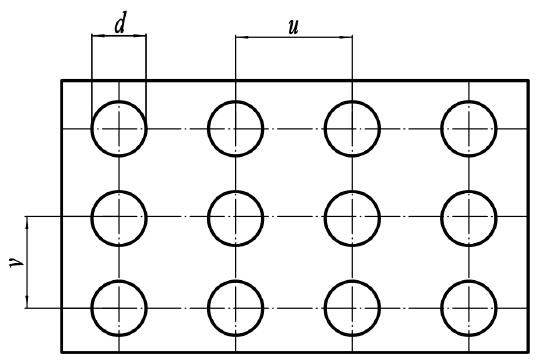
Figure 2. Rectangular arrangement of pit structure.